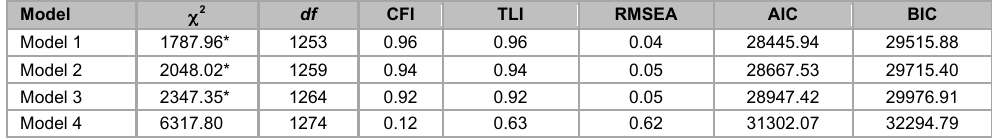
Fit statistics for the competing measurement